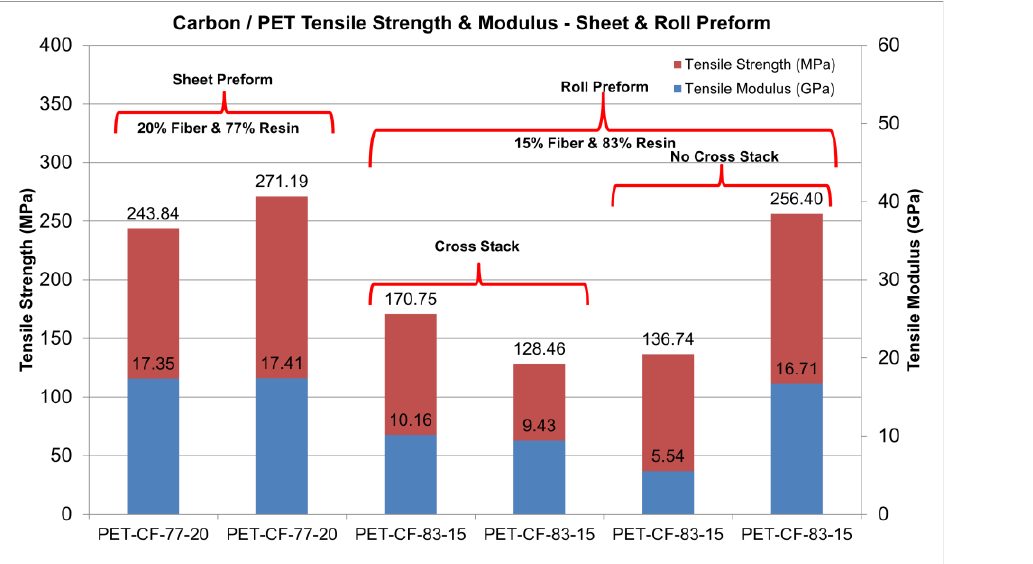
Figure 6. Comprehensive summary of tensile strength and tensile modulus for ‘roll’ and ‘sheet’ form C/PET.